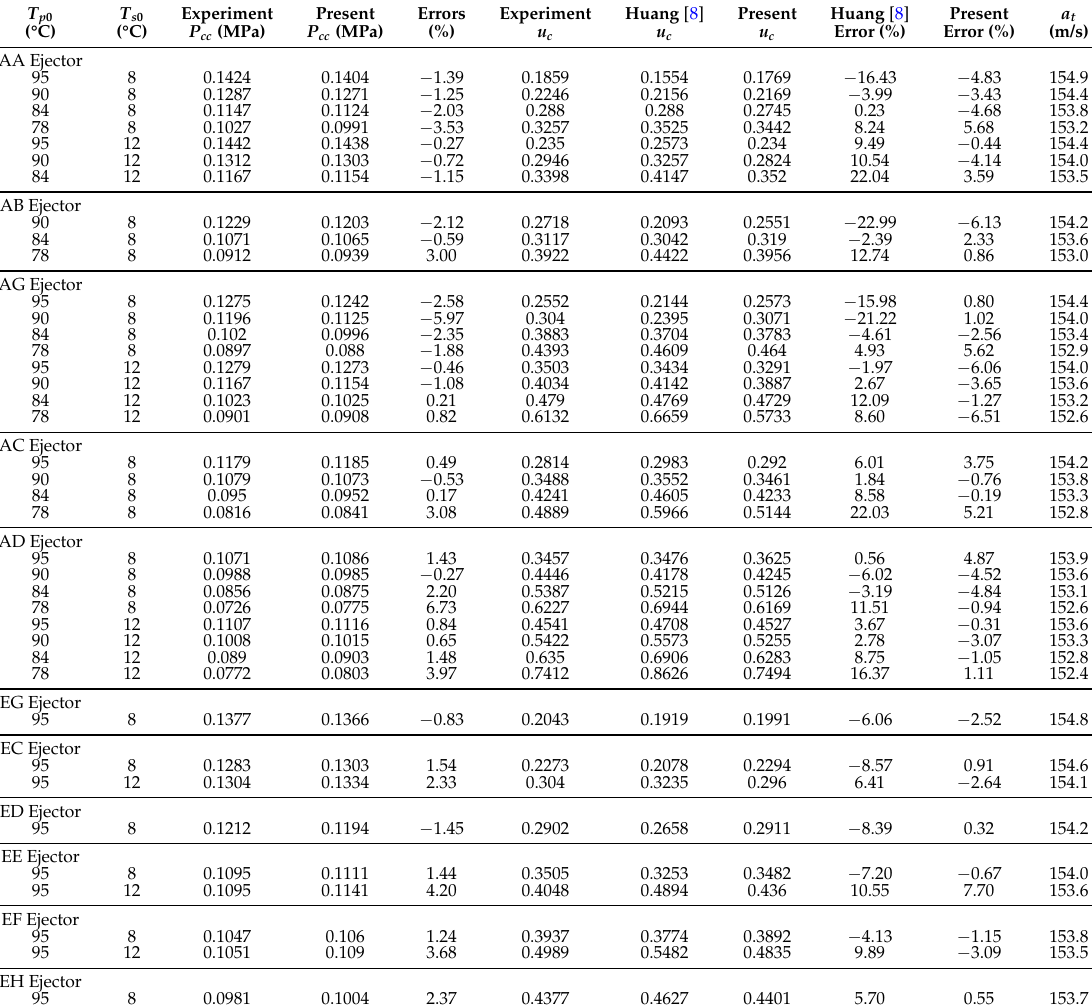
Table 3. Comparisons between critical point model and the experiment results for R141b